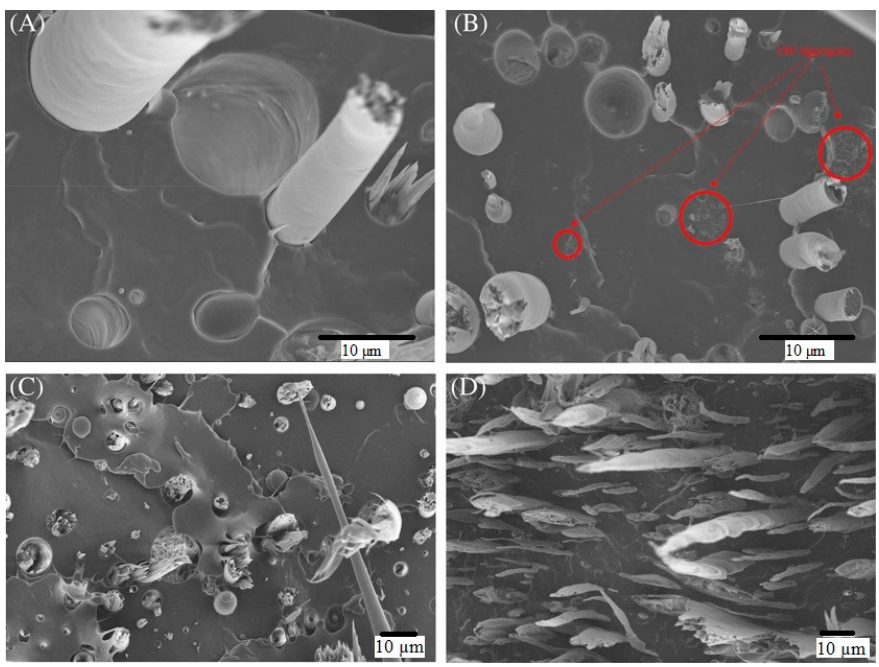
Figure 6. SEM micrographs of fracture surface of filaments of ( A ) 20 wt% TLCP/PP; ( B ) 20 wt% TLCP/1 wt% CNTs/PP; ( C ) 20 wt% TLCP/16 wt% MAPP/PP; ( D ) 20 wt% TLCP/1 wt% CNTs/16 wt% MAPP/PP. With permission [28].